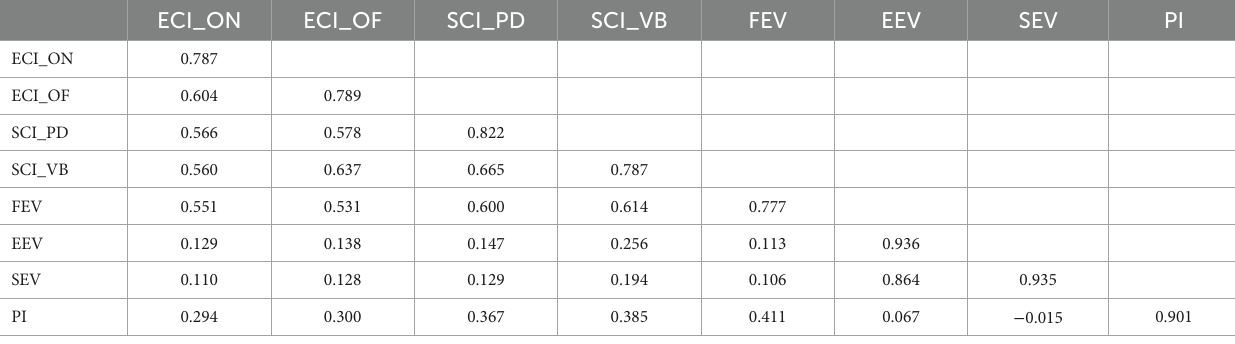
TABLE 3 Discriminant validity and the